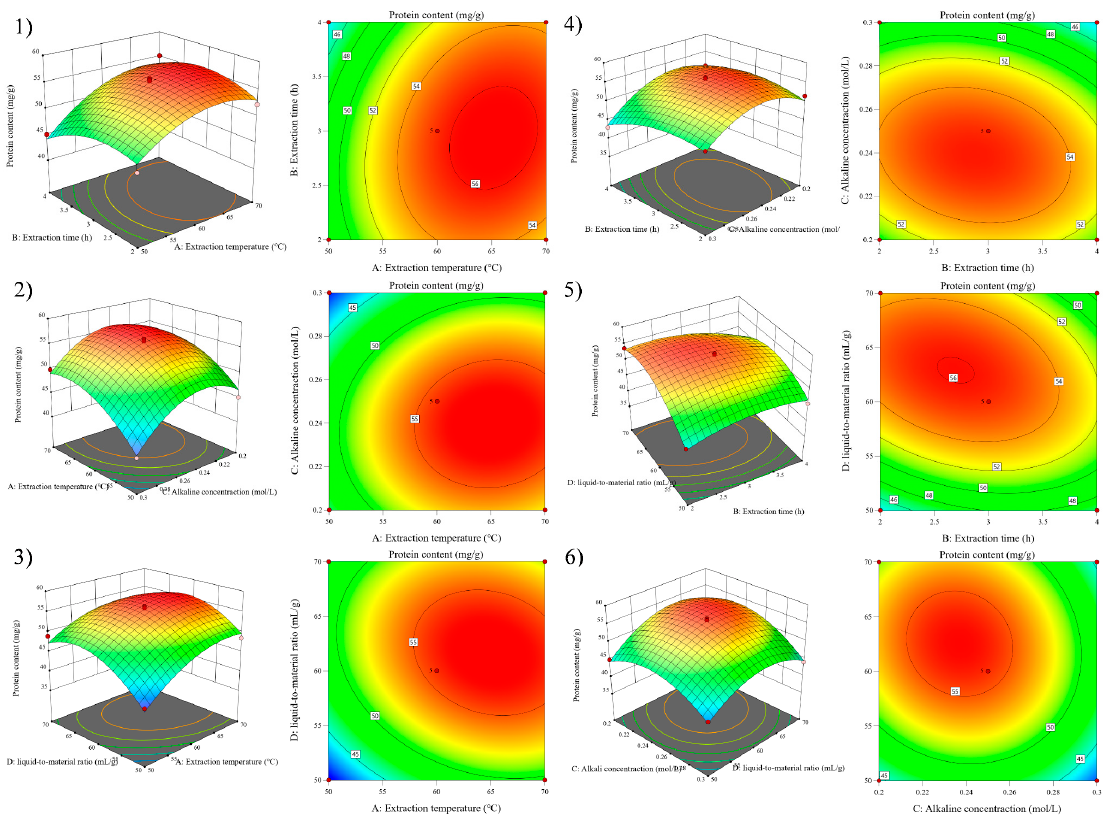
Figure 4. Response surface graphs ( 1 – 6 ) show the effect of the interaction of various experimental fac- tors on protein content. factors on protein